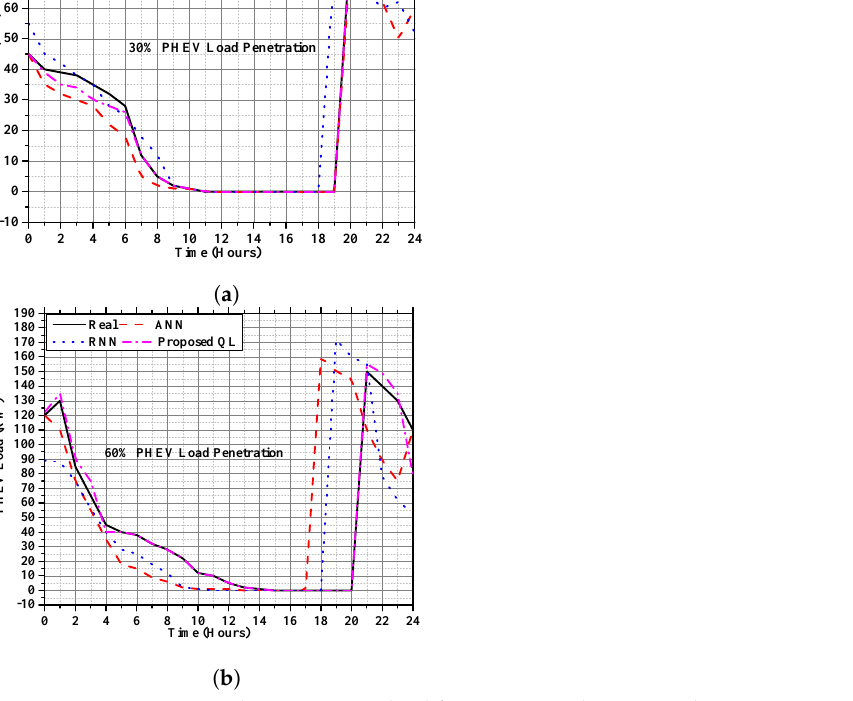
Figure 8. Cooperative charging PHEV load forecasting with a 30% and 60% penetrations. ( a ) Cooper- ative charging PHEV load forecasting with a 30% penetration. ( b ) Cooperative charging PHEV load forecasting with a 60%